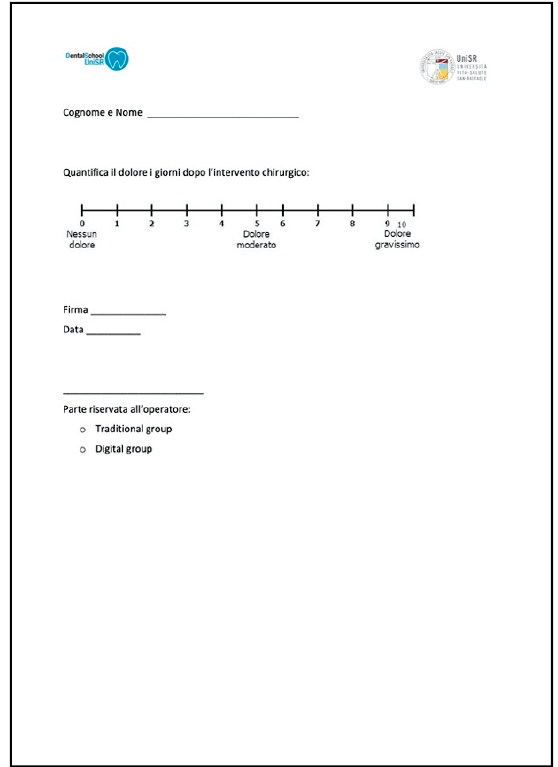
Figure A4. Questionnaire 4.